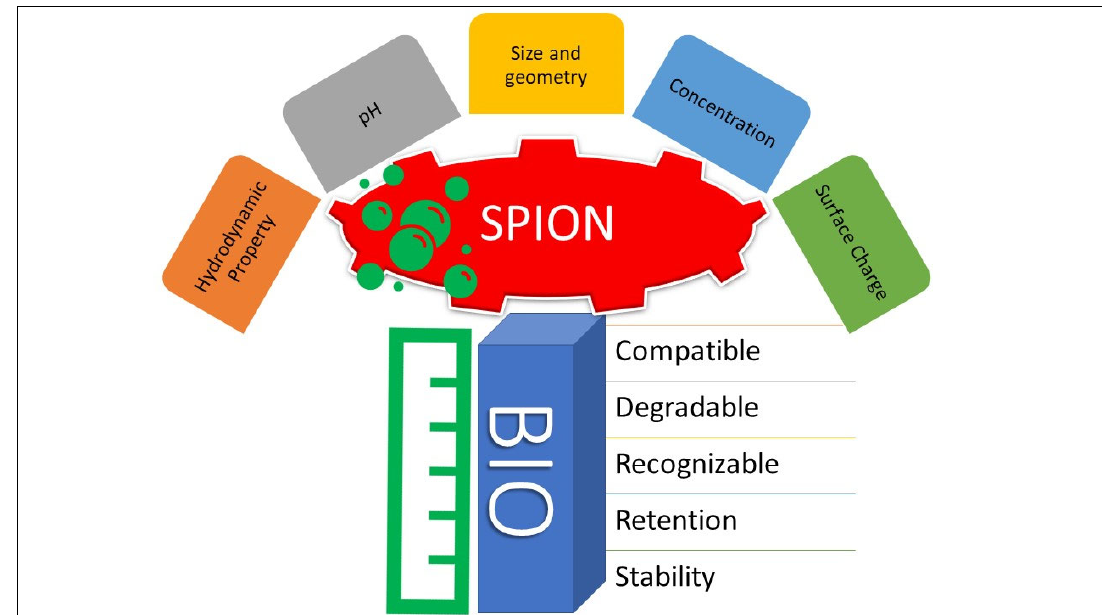
Figure 1. Desired characteristics and functional properties of SPIONs.